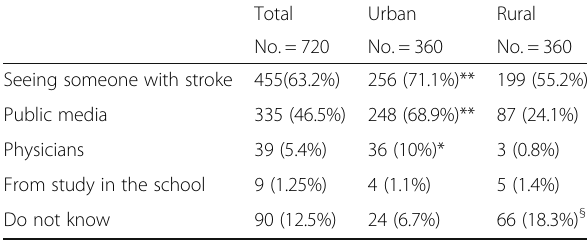
Table 2 Source of knowledge of cerebro-vascular stroke among urban and rural participants Total